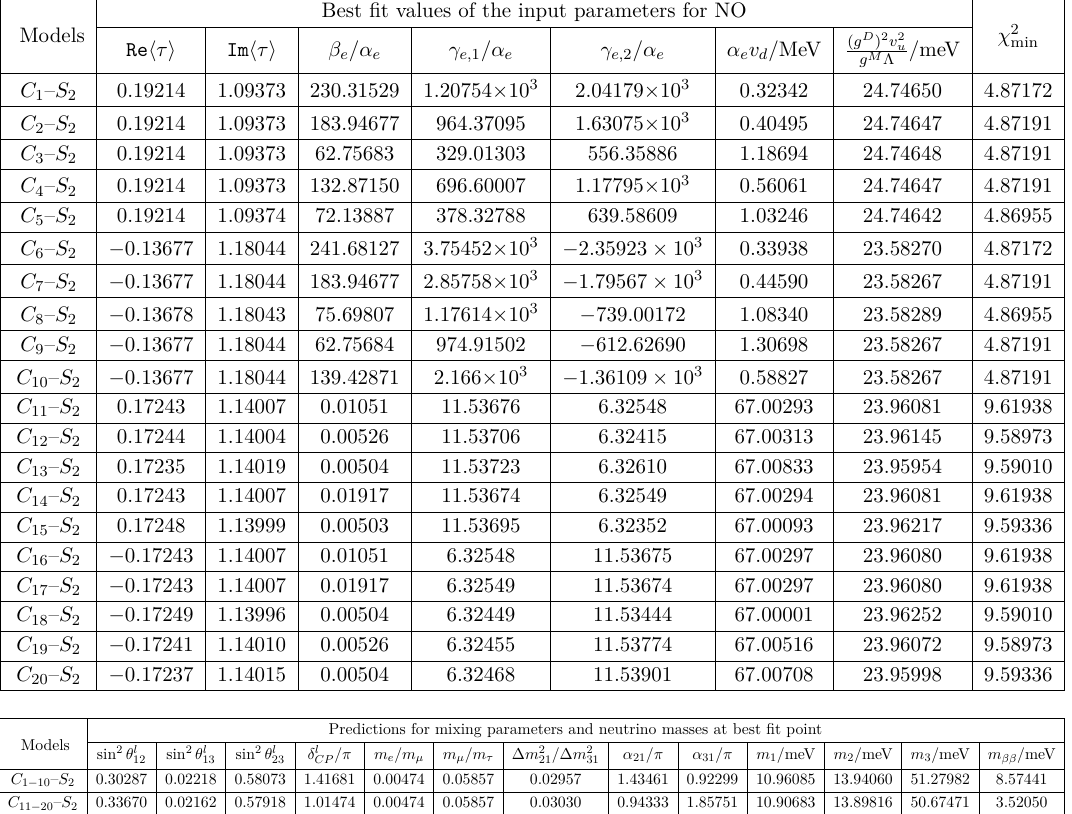
Table 5 . The best fit values of the input parameters at the minimum of the χ 2 for NO neutrino masses. We give the predictions for neutrino mixing angles θ phase δ as well as Majorana CP violating phases α CP and the effective mass m in neutrinoless double beta ββ